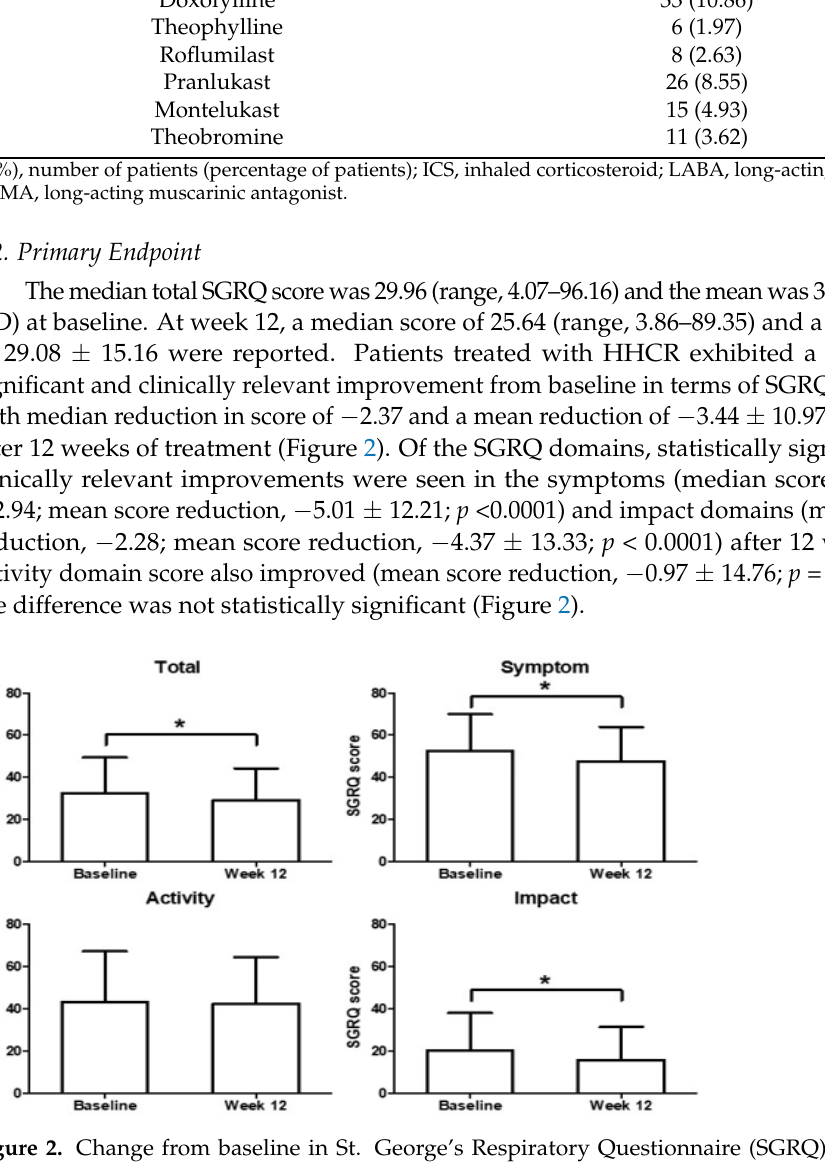
Figure 2. Change from baseline in St. George’s Respiratory Questionnaire (SGRQ) total scores, activity domain, impact domain, and symptom domain. p -value < 0.0001 (Cf. Activity p -value: 0.0971) Wilcoxon’s signed -rank test.*: Statistically significant difference.